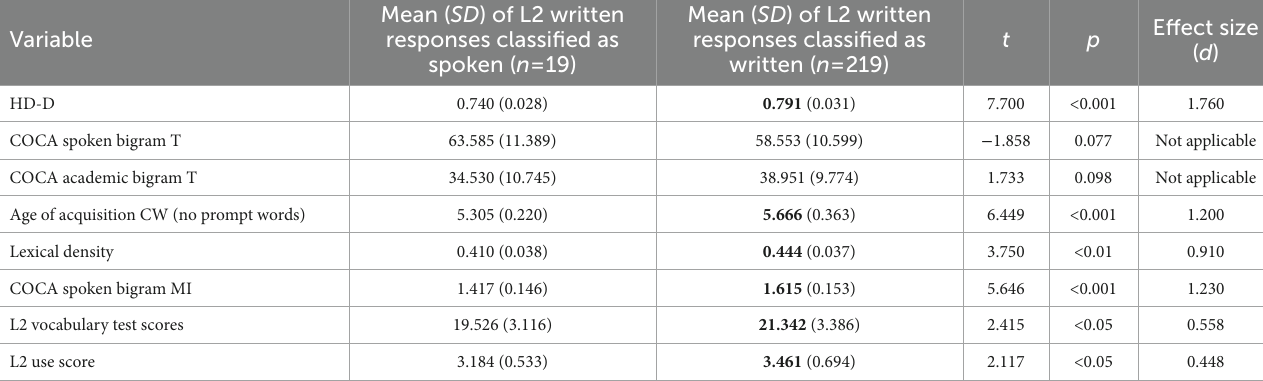
TABLE 6 t statistics for t -test results between L2 written responses classified as spoken ones and those classified as written ones.